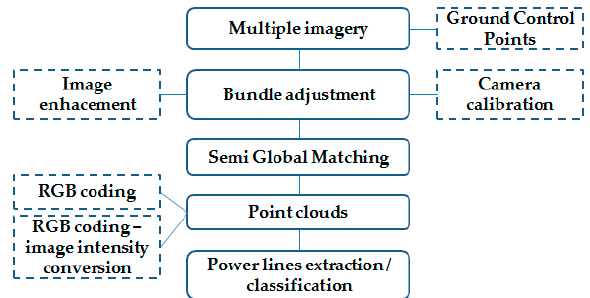
Figure 5. Pattern for generating power lines point clouds from unmanned aerial vehicle (UAV) imaging data (dotted lines indicate optional stages).